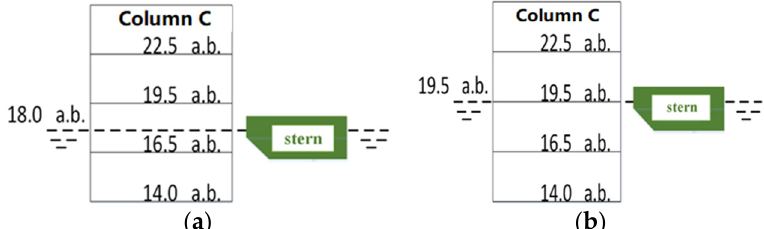
Figure 2. The collision height of the supply ship and support platform . ( a ) Striking the strong frame (H1); ( b ) Impact between strong frames (H2). a.b. is the abbreviation of above baseline, which means the height from the baseline. H1 means the collision height equal to 18.0 m, while H2 means the collision height is equal to 19.5 m. Frame refers to the frame structure composed of the stiffened plate and circumferential truss in the column of a semi-submersible platform.